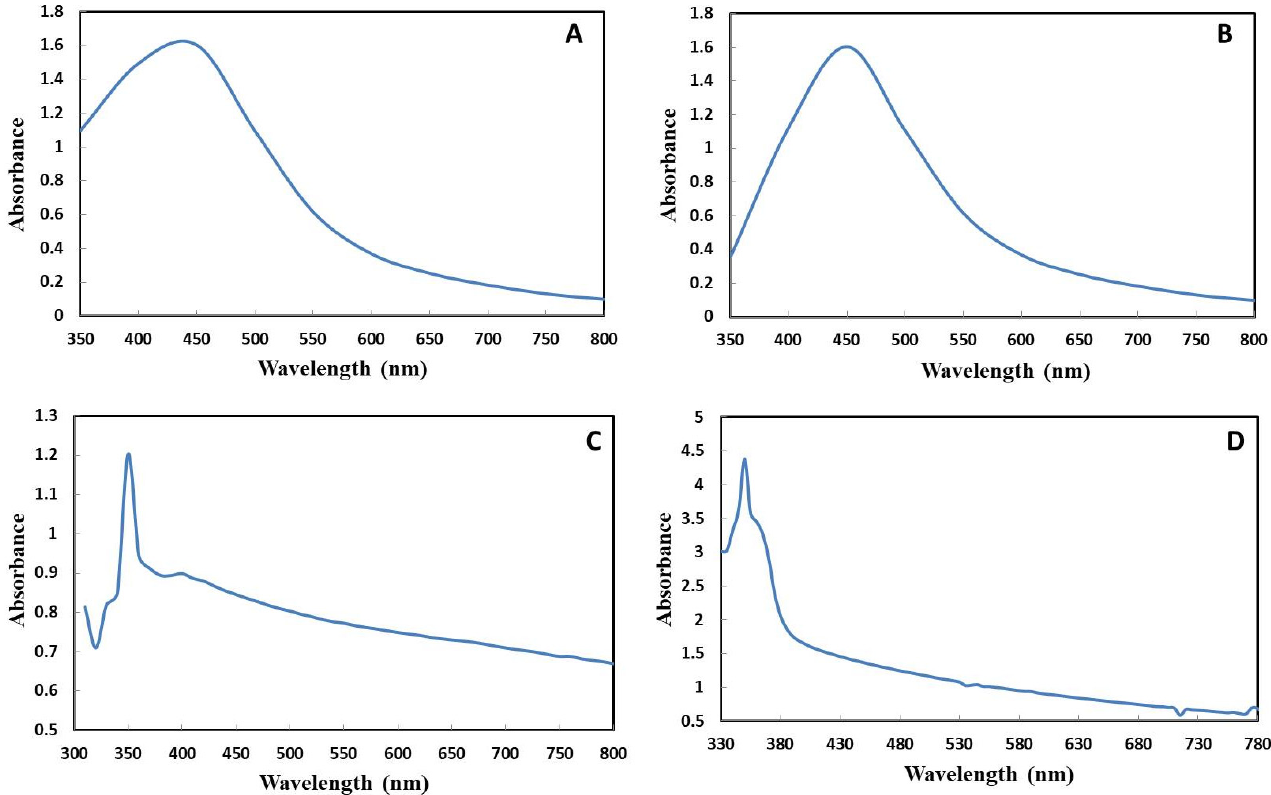
Figure 2. UV-visible spectra. ( A ) Control AgNPs. ( B ) UV-C mediated AgNPs. ( C ) Control ZnONPs. ( D ) UV-C mediated ZnONPs.